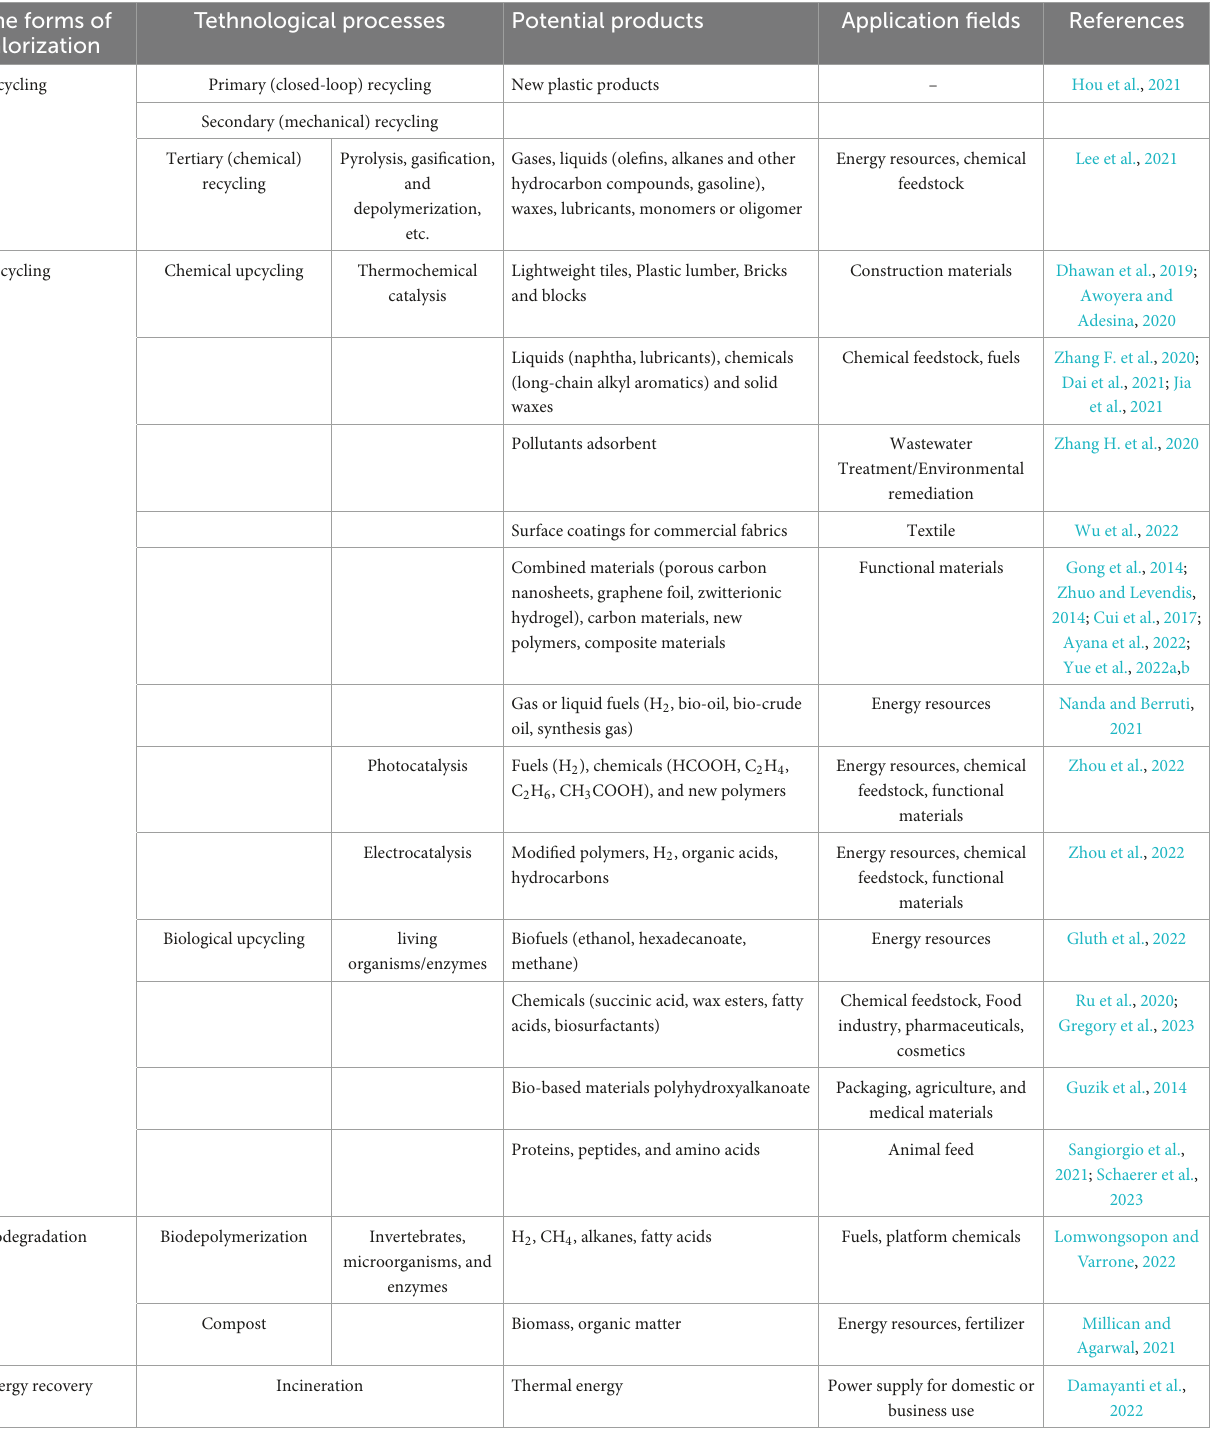
TABLE 4 Potential products and application area of waste plastic valorized via different strategies and technical